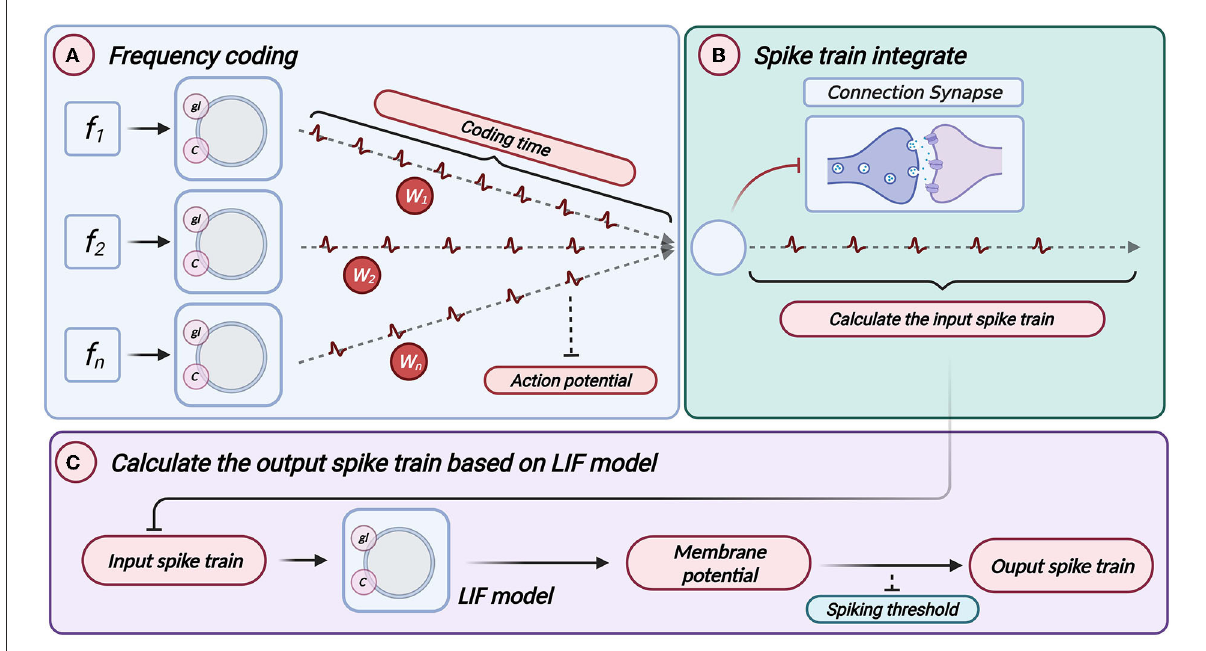
FIGURE3 Information transmission of Linear LIF model. (A) All inputs are encoded as a spike train, multiplied by a weight. This is the information integration shown in the left part of the figure. (B) Add all input spikes to get the input spike sequence of the neuron. (C) The output action potential is obtained according to the input spike sequence through the LIF neuron’s information processing